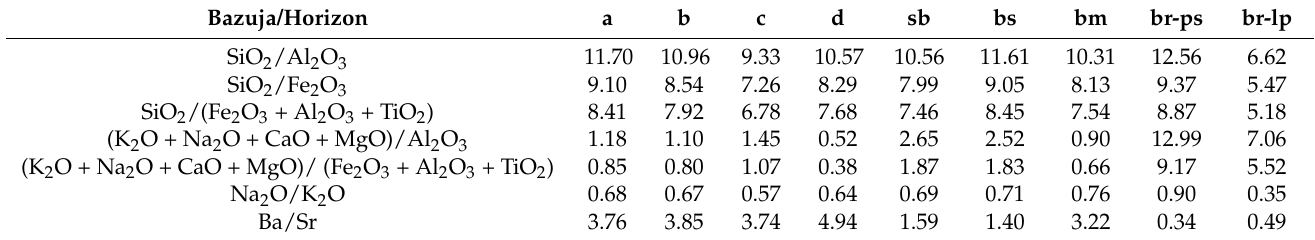
Table 3. Mean weathering index values in soil profiles (a, b, c, and d horizons), stream sediments (sb), older (bs) and younger (bm) ponor (swallow hole) overbank sediments, and not weathered marls (ar-lp) and sandstones (ar-ps) in the river Bazuja